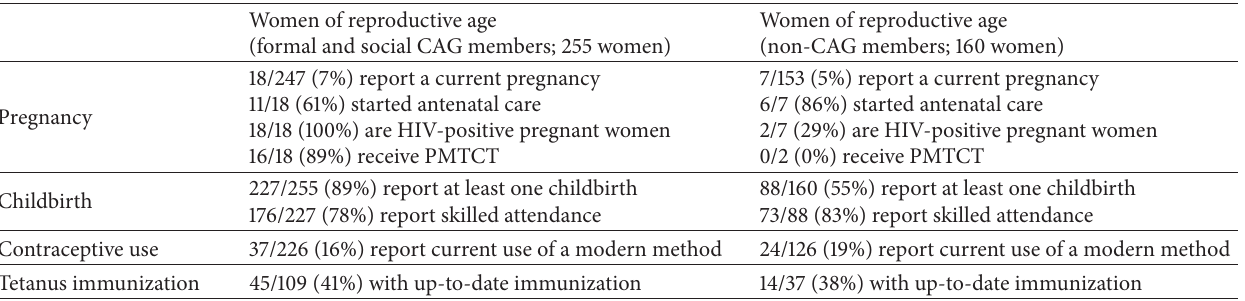
Table 3: Healthcare for women of reproductive